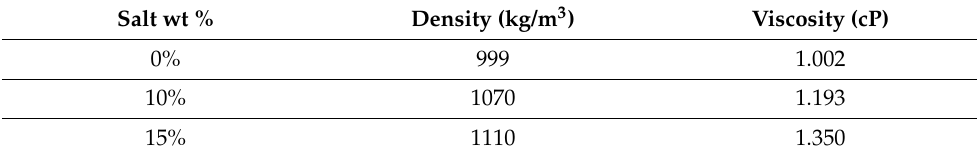
Table 2. The 3D microfluidics behavior against variations in fluid properties at 21 ◦ C [33].